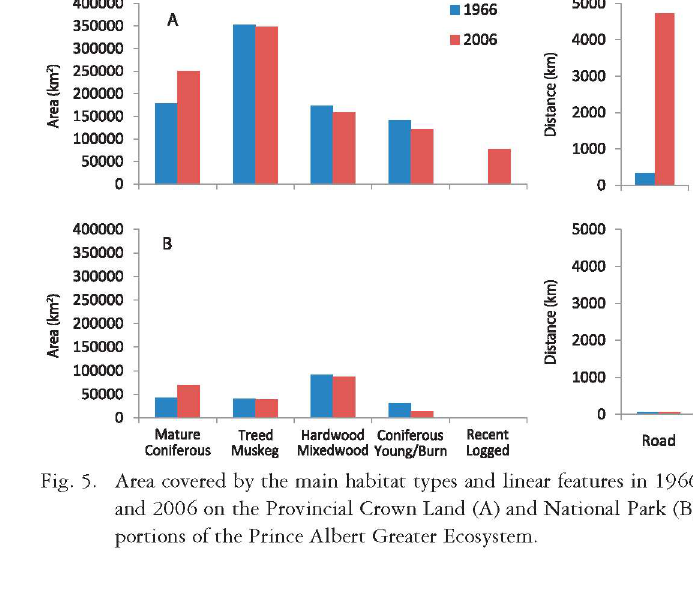
Table 2. Changes in habitat patch metrics (x ± s.e.) between 1966 and 2006 for the National Park portion of Prince Albert Greater